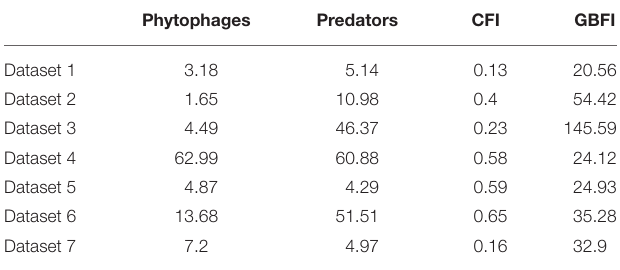
TABLE 5 | Mean abundance of phytophagous and predatory invertebrates, the gray partridge chick-food index (CFI) and general farmland bird index (GBFI) in the seven studies.